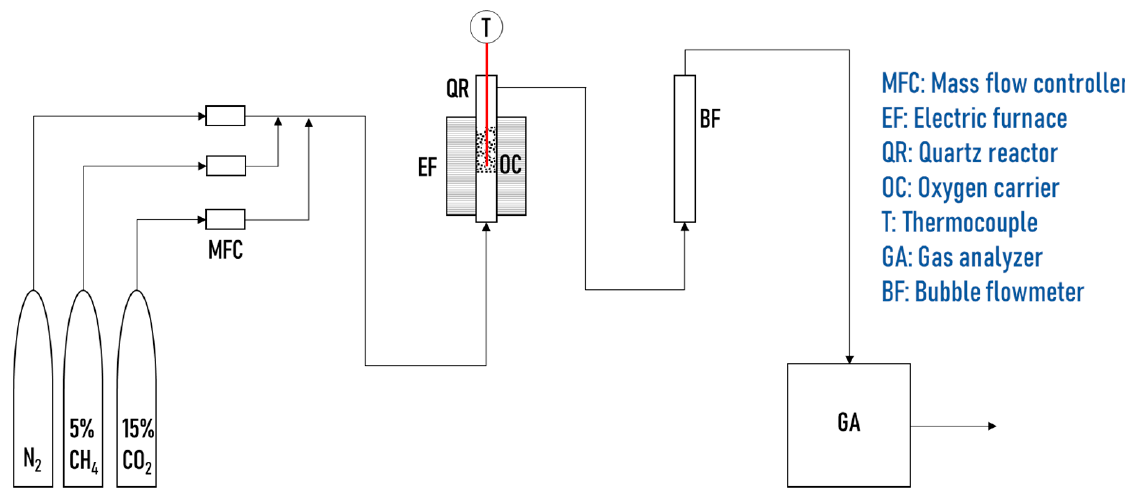
Figure 2. Experimental set-up for fluidized-bed reaction tests.